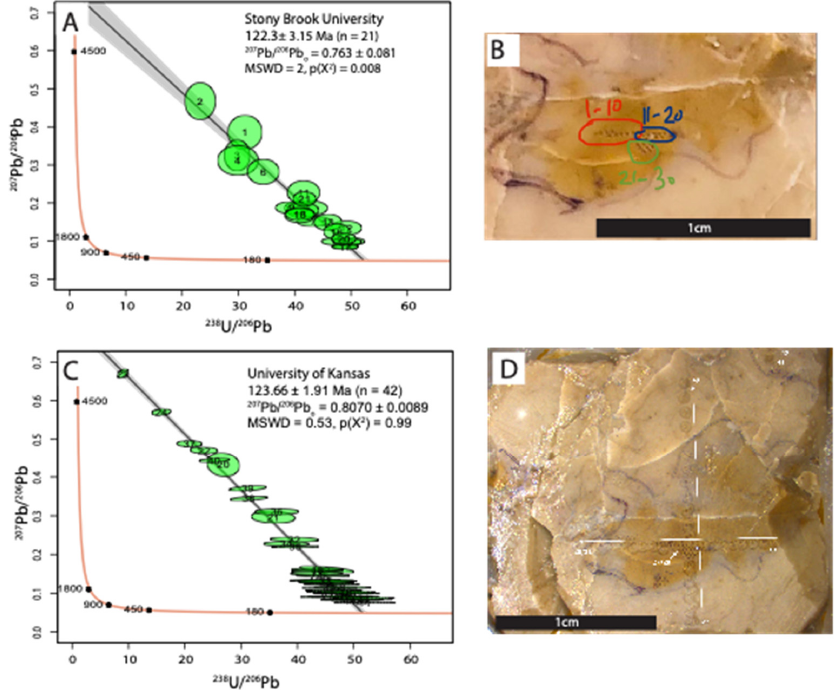
Figure 7. ( A ) Tera–Wasserburg concordia plot of LA-ICP-MS data from Stony Brook University. ( B ) Polished slab with spots for the SBU isochron circled and numbered. The numbers go from left to right and from top to bottom when there are stacked holes. ( C ) Tera–Wasserburg concordia plot of LA-ICP-MS data from the University of Kansas (KU). ( D ) Polished slab with the spots for the KU isochron indicated with arrows and numbers. There is an extra set of spots outside of the region indicated by the arrows from a previous analysis session.